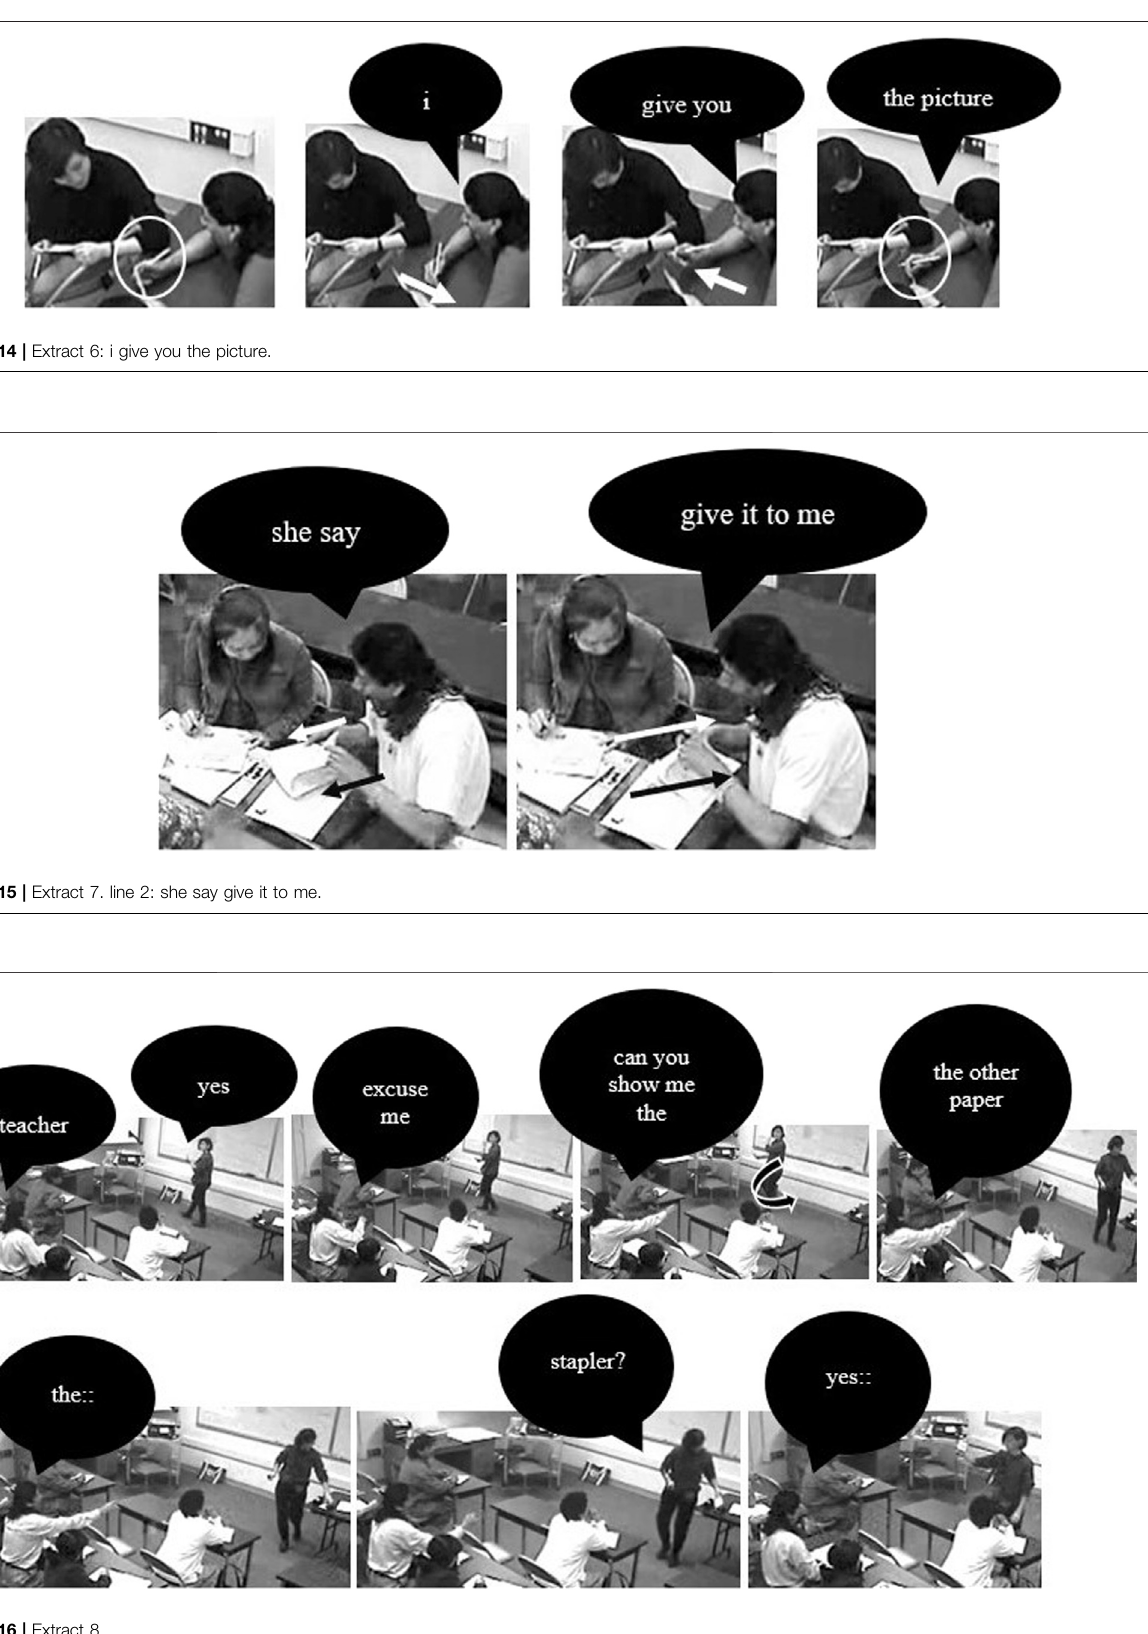
FIGURE 16 | Extract